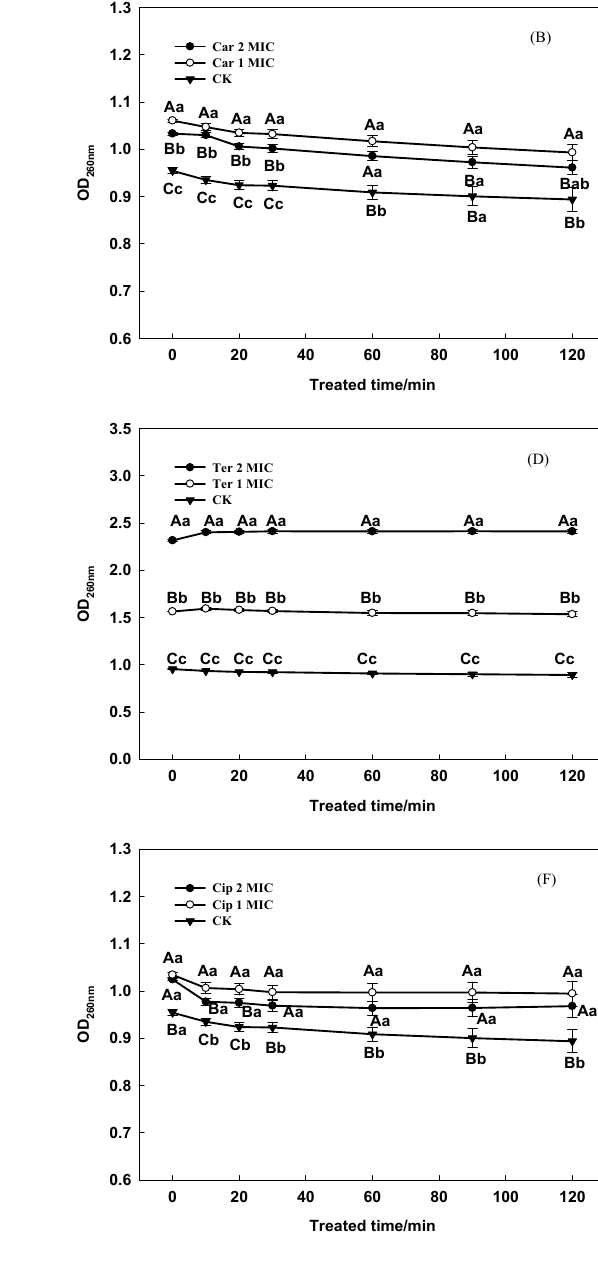
Figure 5. Effects of Str ( A ), Car ( B ), Amp ( C ), Ter ( D ), Tmp ( E ), and Cip ( F ) on cell membrane damage by PAO1-CE. Values represent the means ± SE (n = 3). Different letters mean a significant difference between the groups (capital letter, p < 0.05; small letter, p < 0.01).